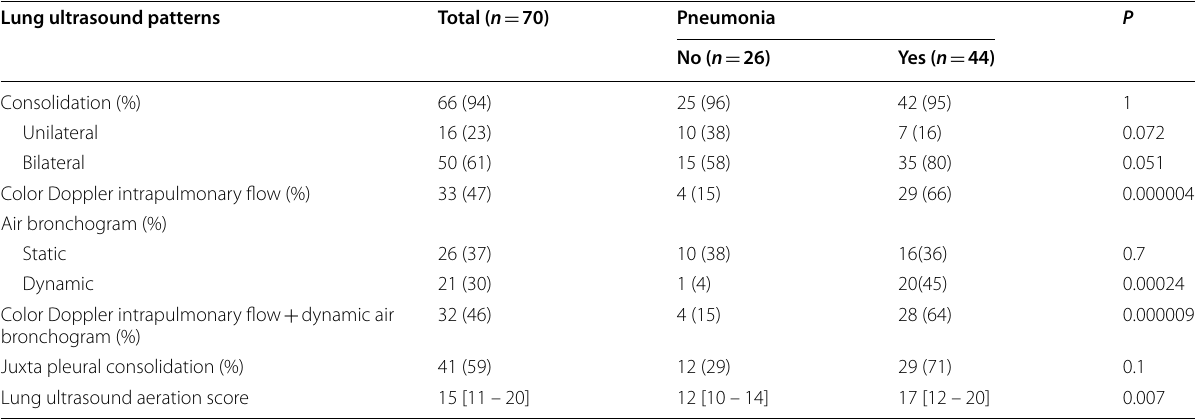
Quantitative variables are expressed as median [interquartile range] and qualitative variables as number and percentage (%)